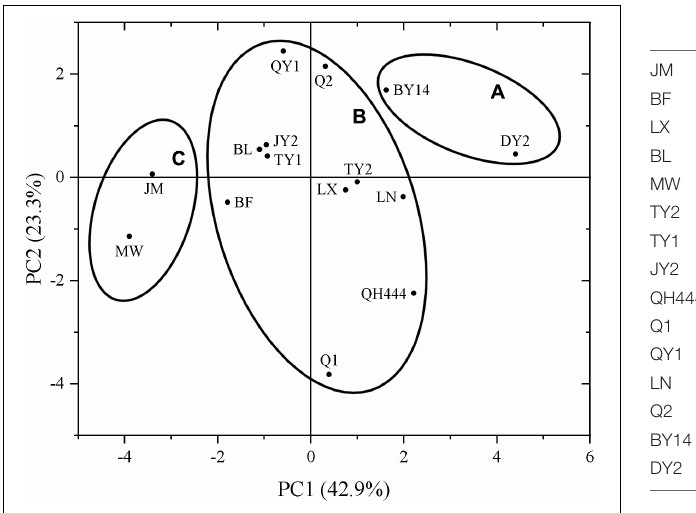
FIGURE 6 | Principal component analysis of different oat varieties.